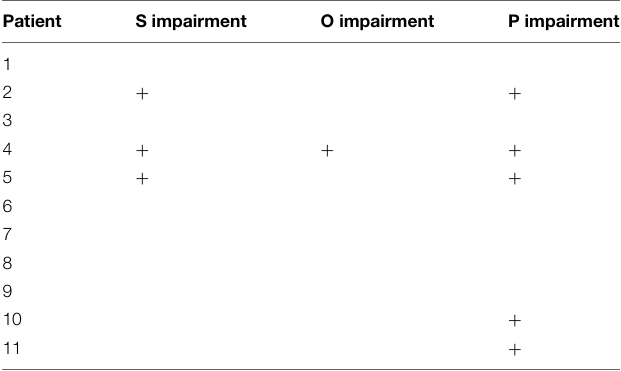
TABLE 3 | Summary of reading impairments in the current patient